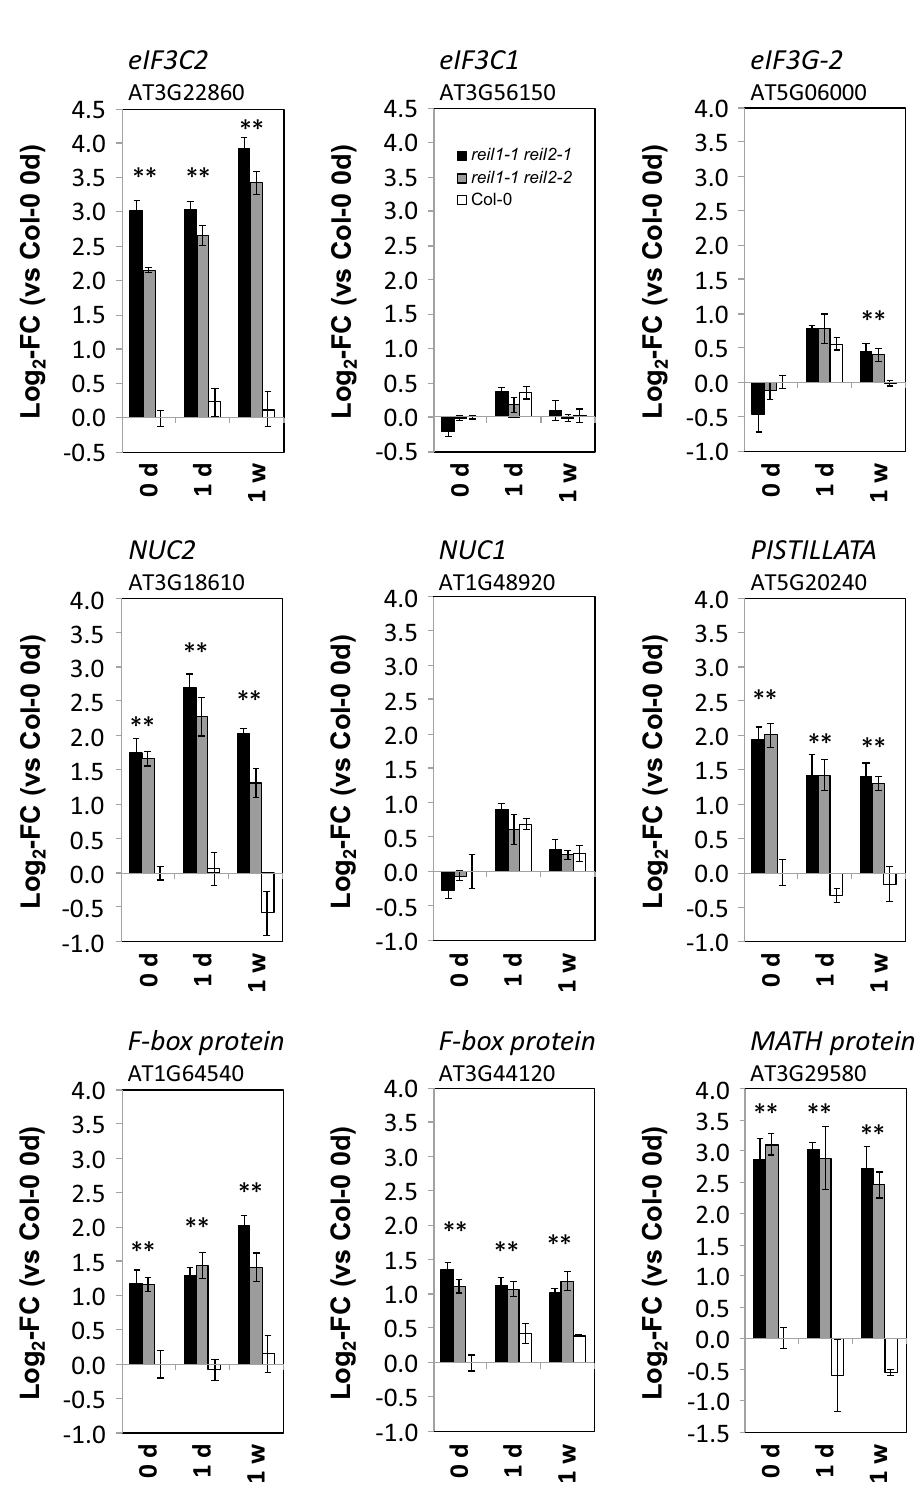
Figure 8. Differential expression of six genes that accumulate constitutively in reil1-1 reil2-1 and reil1-1 reil2-2 double mutant roots (means + / − standard error, n = 3). eIF3C2 , eIF3C1 and eIF3G2 code for paralogs of the eukaryotic translation initiation factor 3 multi-protein complex. NUC1 and NUC2 are plant nucleolins. Asterisks indicate P < 0.05 (heteroscedastic Student´s t-test) of comparisons to Col-0 at the same time point. NUC1 , eIF3C1 and eIF3G2 are added to this figure to demonstrate the specific mutant effect on paralog